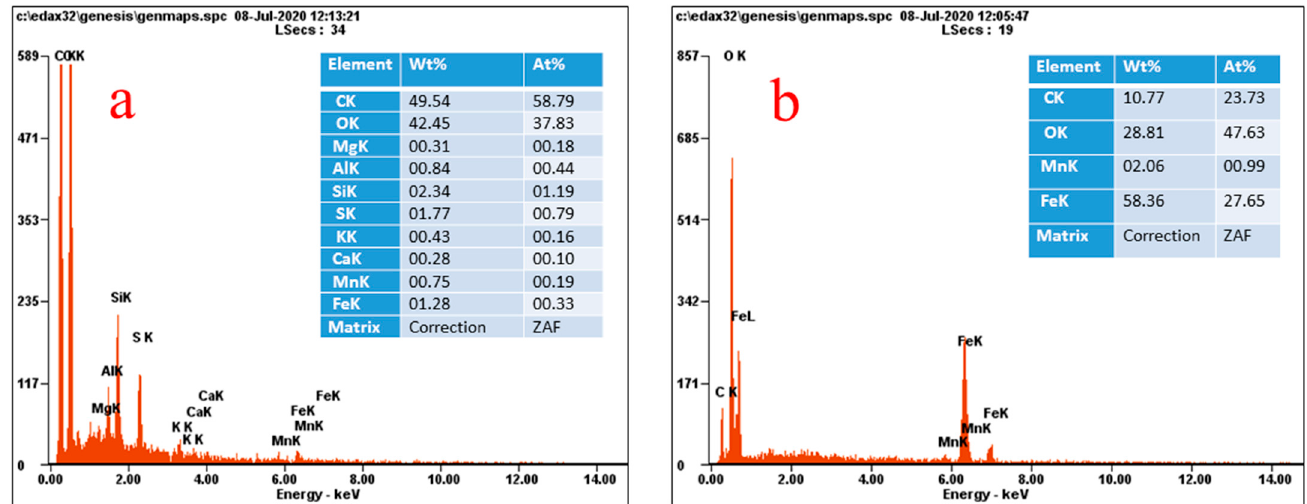
Figure 2. Energy dispersive X-ray (EDX) spectra of ( a ) GO and ( b ) MnO 2 /MrGO . The SEM micrographs of GO and MnO 2 /MrGO, are presented in Figure 3a,b. The